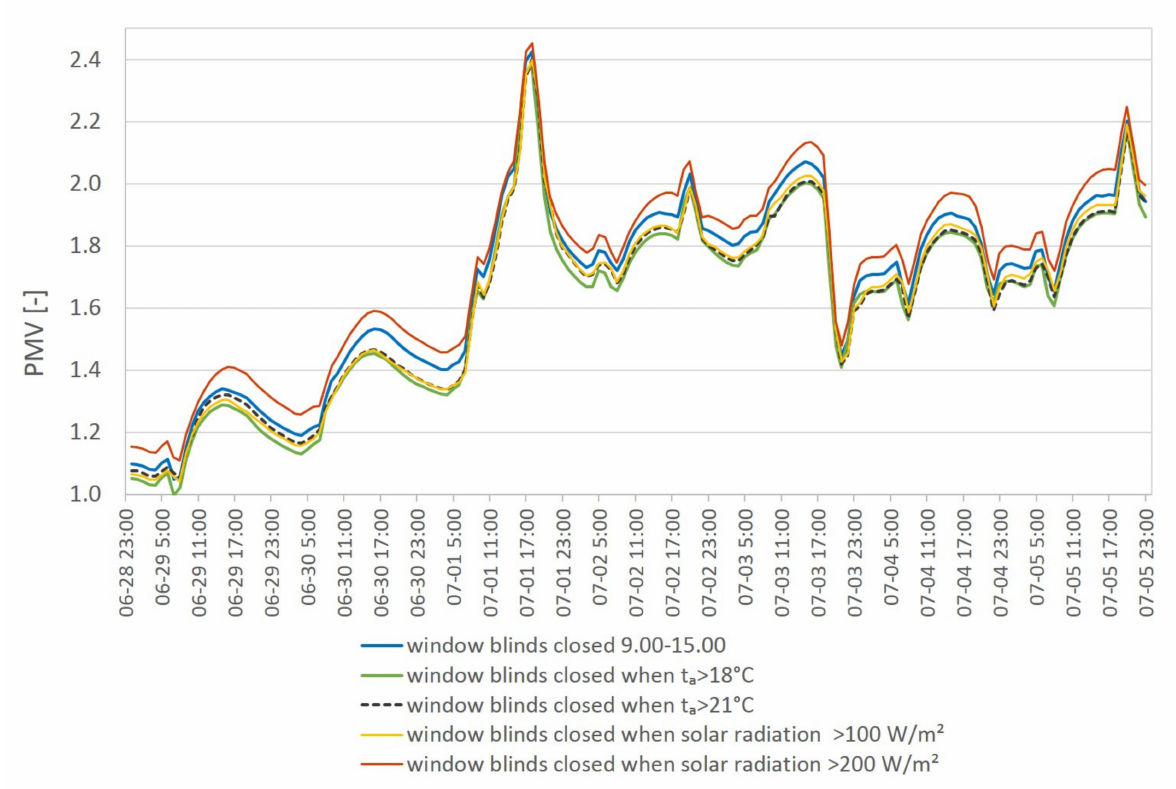
Figure 15. Distribution of the predicted average assessment index for the selected